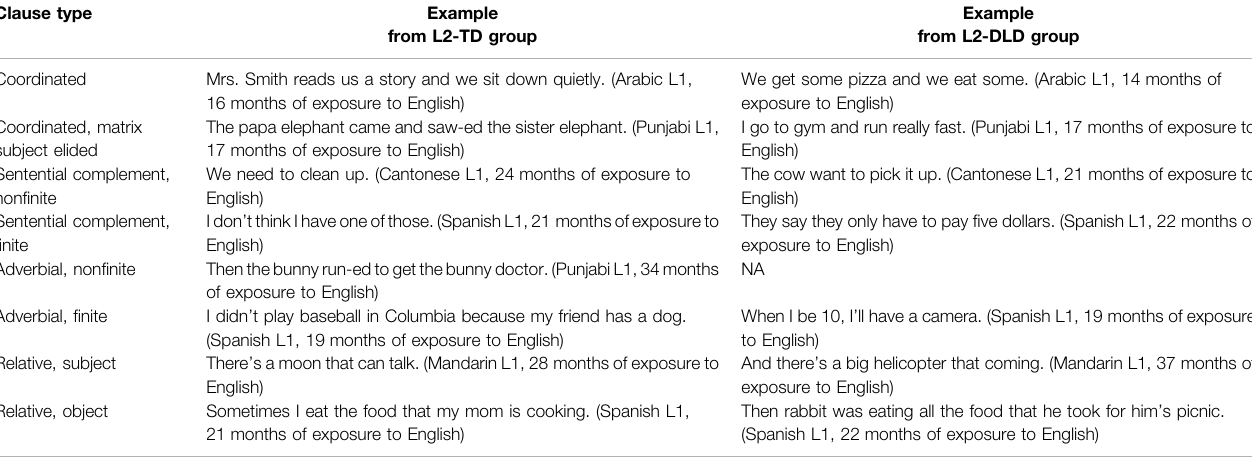
TABLE 2 | Examples of complex sentences by